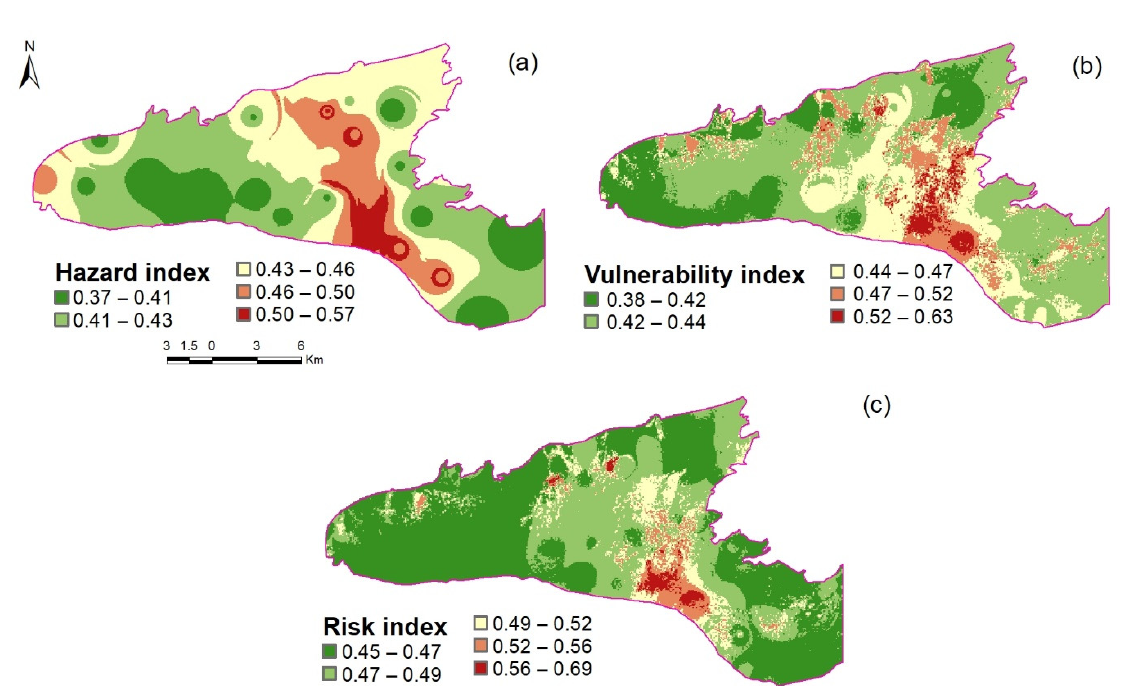
Figure 5. Result at Level 2: ( a ) hazard; ( b ) vulnerability; ( c ) risk.